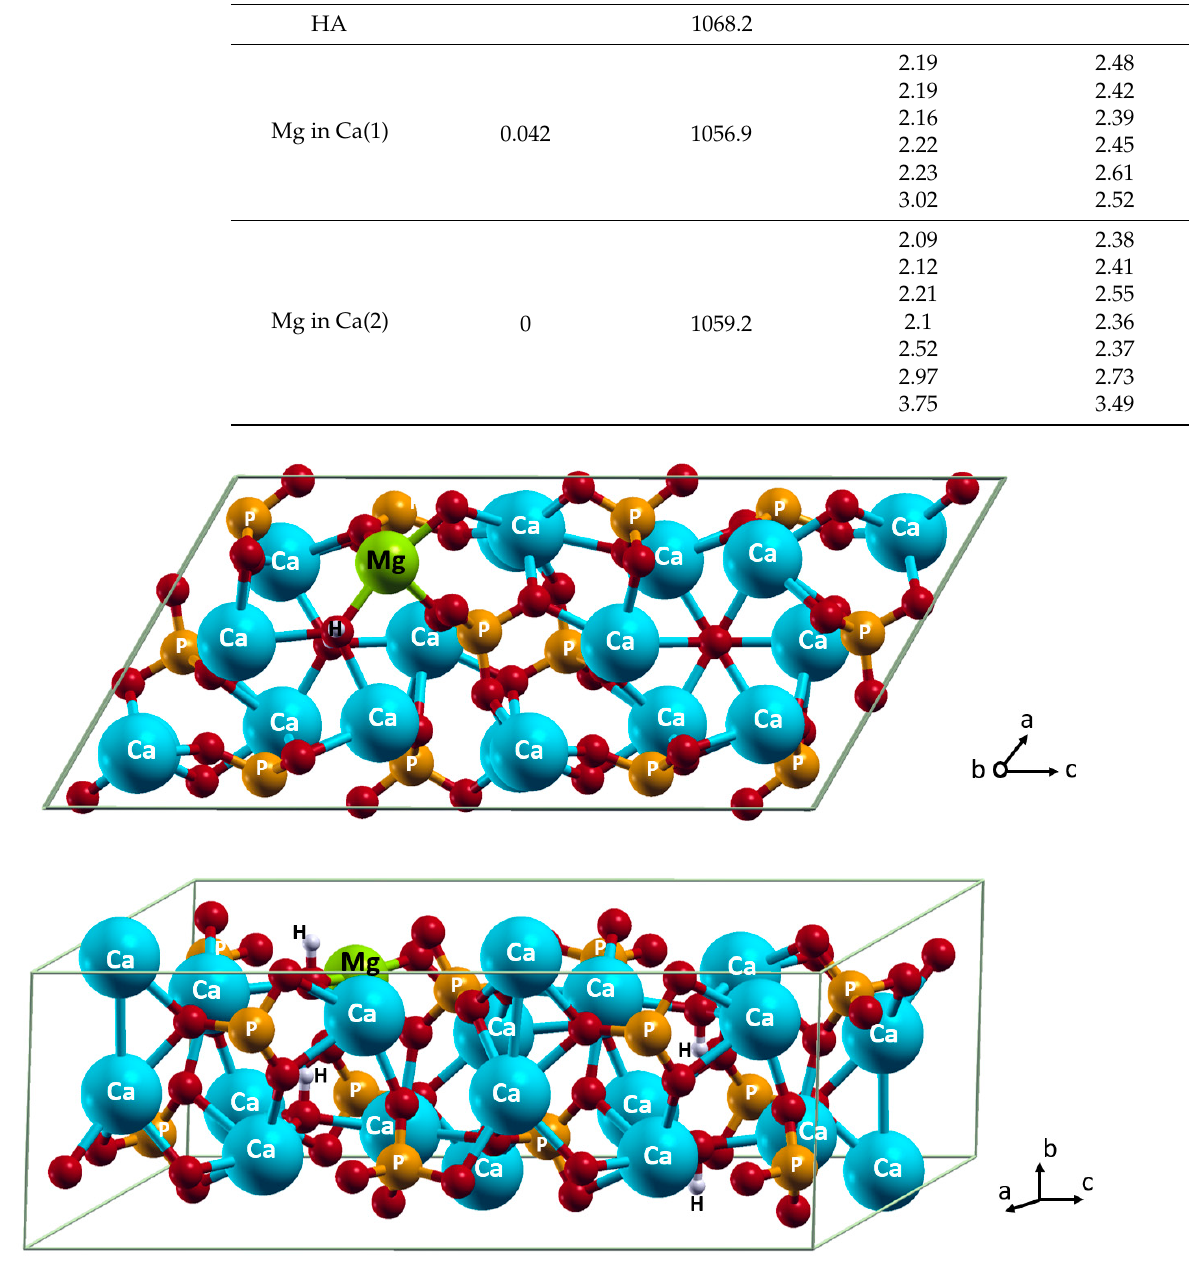
Figure 2. Incorporation of Mg 2+ in Ca(2) position. Color coding: Ca–cyan; P–orange; O–red; H–white; Mg–light green. For clarity, all atoms except oxygen are named.